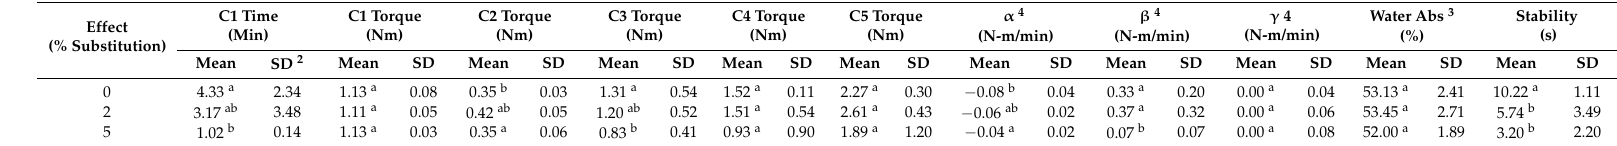
Table 7. Main effect of SSL on Mixolab operational parameters 1 .